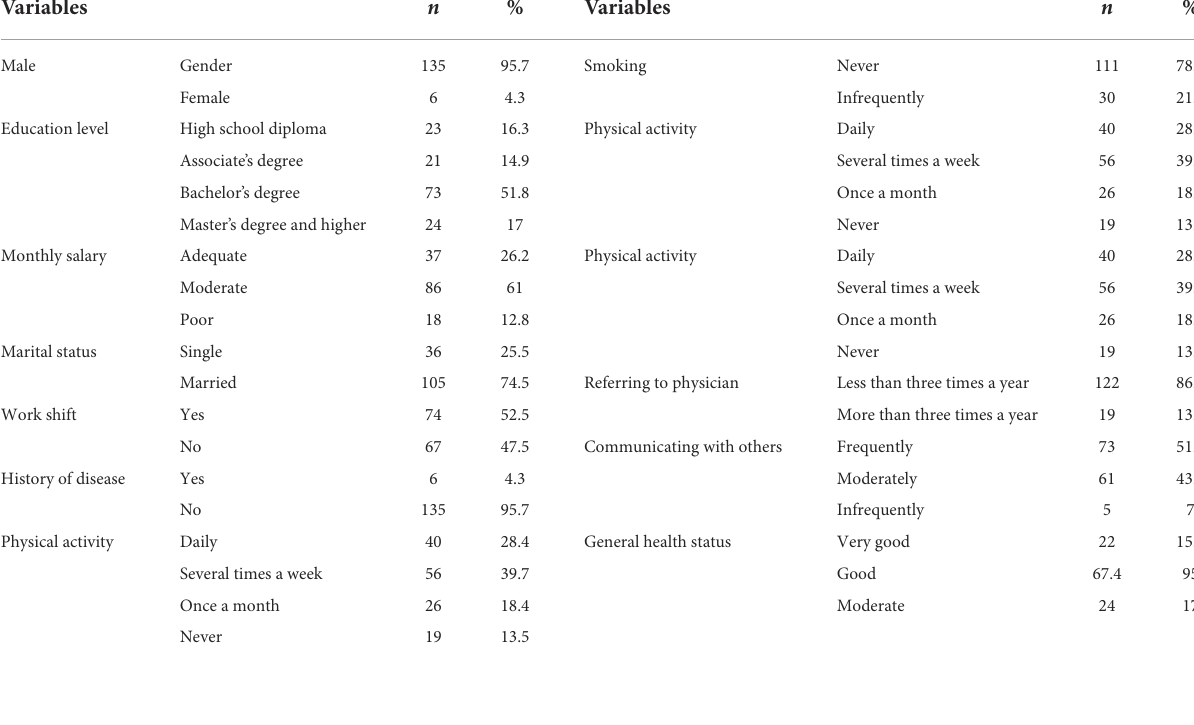
TABLE 1 Descriptive statistics of the participants socio-demographic and other